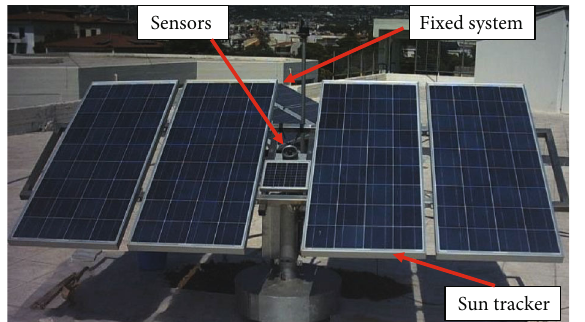
Figure 2: Dual-axis sun tracker active and fi xed system, Patras,